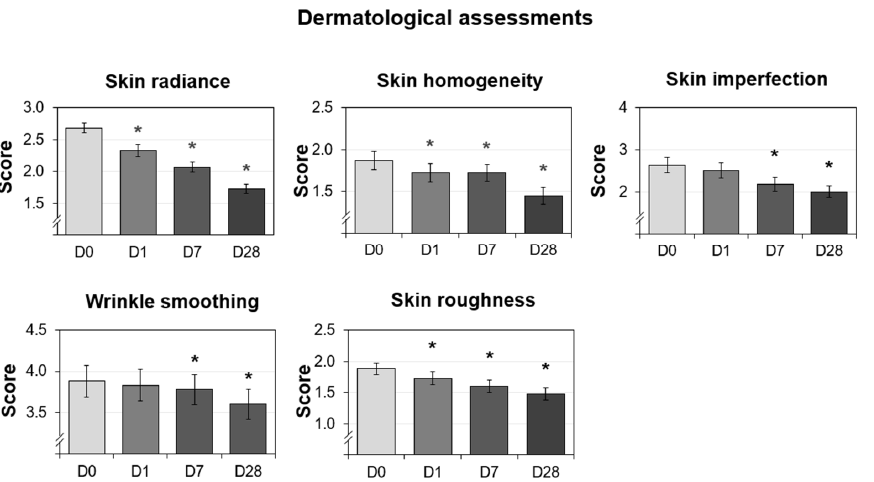
Figure 6. Dermatological assessments performed on 30 Caucasian subjects after nightly use of the cream (test product) during 28 days. The data presented are the mean ± SD at D0 (baseline), D1, D7, and D28. Statistical comparisons of the mean values to D0 were achieved by a Wilcoxon test (* p < 0.05).